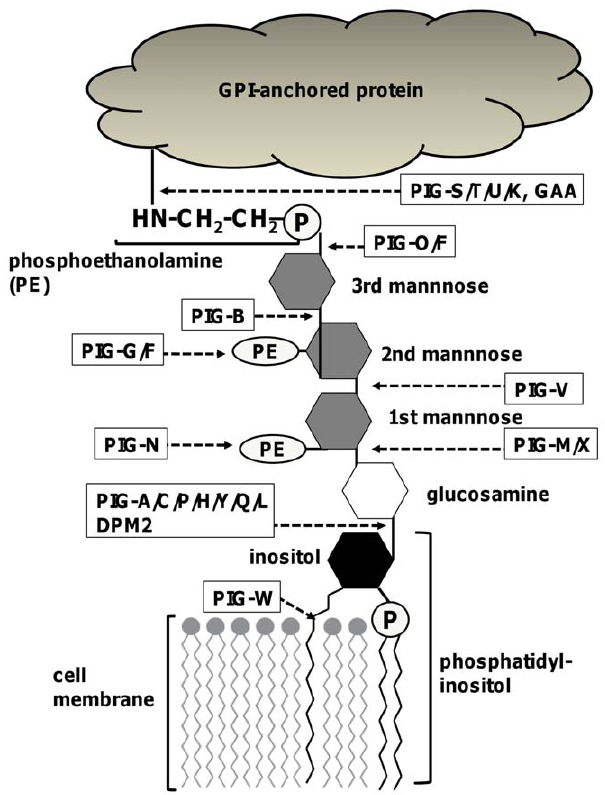
Figure 1. Biosynthesis of the glycosylphosphatidyl inositol (GPI)-anchored protein. Synthesis of GPI-anchored proteins involves multiple reaction steps. Briefly, the first step of GPI anchor biosynthesis is catalyzed by a multi-subunit GPI- N -acetylglucosaminyltransferase comprised of at least 6 different proteins (PIG-A, PIG-C, PIG-H, PIG-P, PIG-Q, PIG-Y). In addition, DPM2 appears to regulate this first step, followed by de- N -acetylation by the PIG-L. PIG-W then attaches an acyl chain to form glucosamine-(acyl)PI. In the next step, three mannose (Man) residues are added sequentially to glucosamine-(acyl)PI, gener- ating Man-Man-Man-glucosamine-(acyl)PI by PIG-M/PIG-X complex, PIG- V, and PIG-B. After the Man-1 and Man-2 conjugation, PIG-N adds ethanolamine phosphates (EtNP) to the Man-1. In the final step of GPI anchor synthesis, PIG-O/PIG-F and PIG-G/PIG-F complexes attach EtNP to the Man-3 and Man-2, respectively, to generate the mature GPI anchor protein.